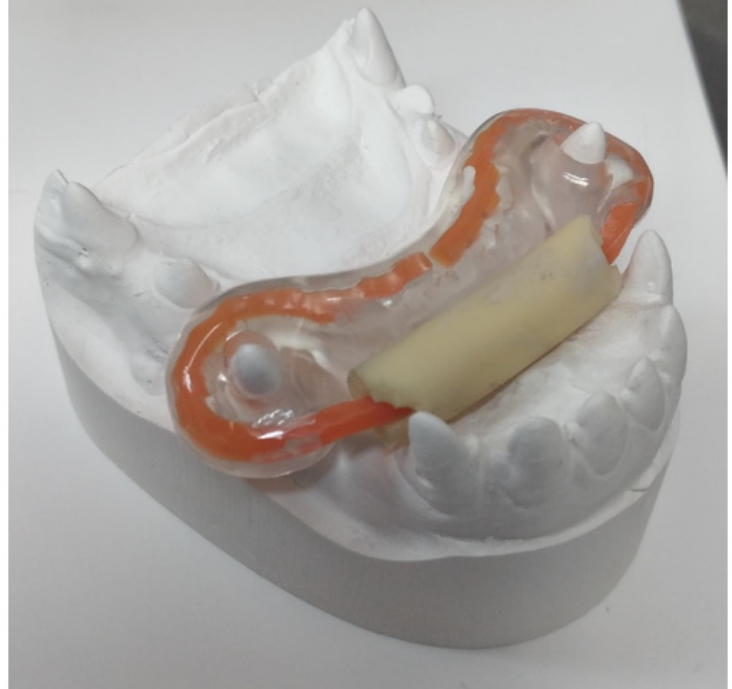
Figure 17. Modification of the activator with a rubber tube.